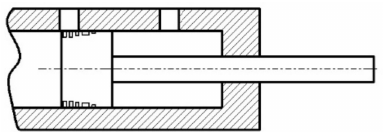
Figure 7. Scheme of an actuator using the piston groove